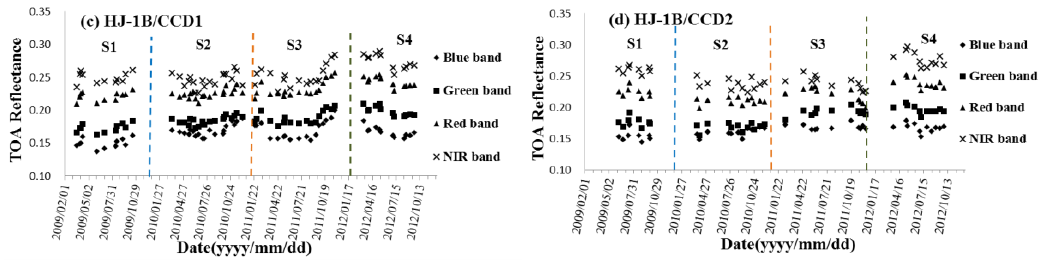
Figure 8. Time series of TOA reflectance of HJ-1/CCDs from 2008 to 2012 in reflective bands: ( a ) HJ-1A/CCD1; ( b ) HJ-1A/CCD2; ( c ) HJ-1B/CCD1; ( d ) HJ-1B/CCD2.